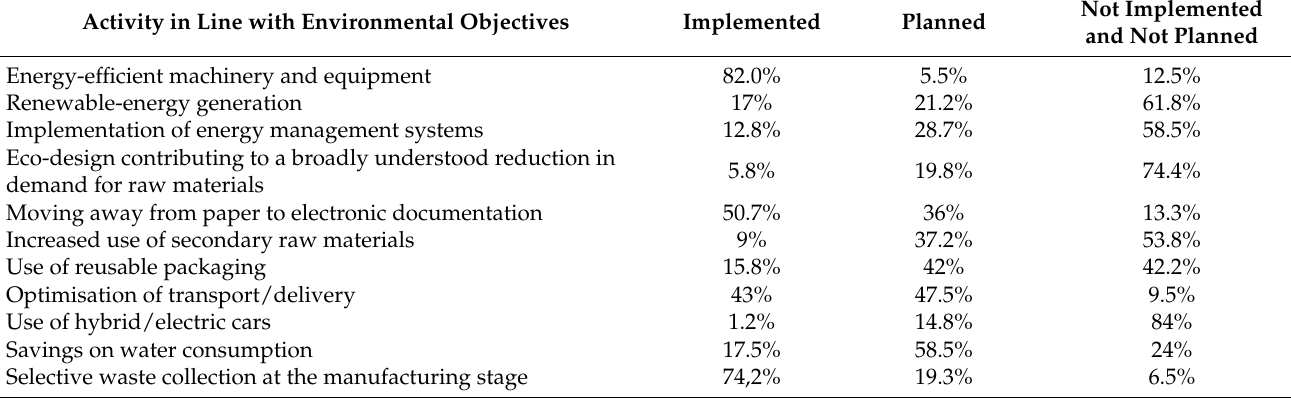
Table 4. Status of the enterprises’ implementation of solutions arising from environmental objectives.